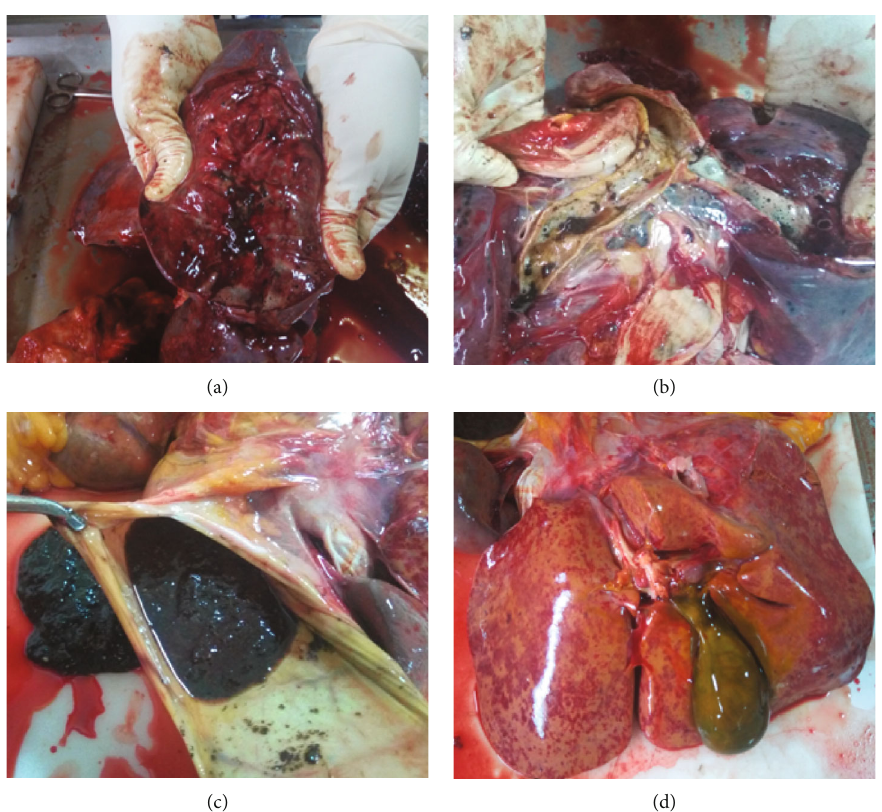
Figure 1: Postmortem fi ndings. (a) Lung with multiple petechiae; it is congested, consolidated, and markedly edematous. (b) Trachea fi lled with semiformed and undigested herbal preparation and erosion of the intima of the trachea. (c) Gastric cavity showing a massive herbal preparation inducing an extensive gastritis. There is hyperaemia and erosion of the gastric mucosa; the wall is thin and distended. (d) Liver with extensive and di ff use petechial bleeds. Gall bladder markedly congested and